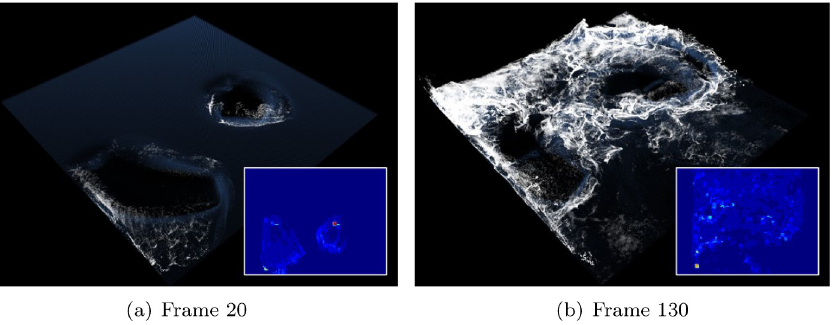
Fig 19. Foam effects with previous method and same scene as Fig 13 (inset image: Refined acceleration map with DANet [68]). (a) Frame 20, (b) Frame 130.